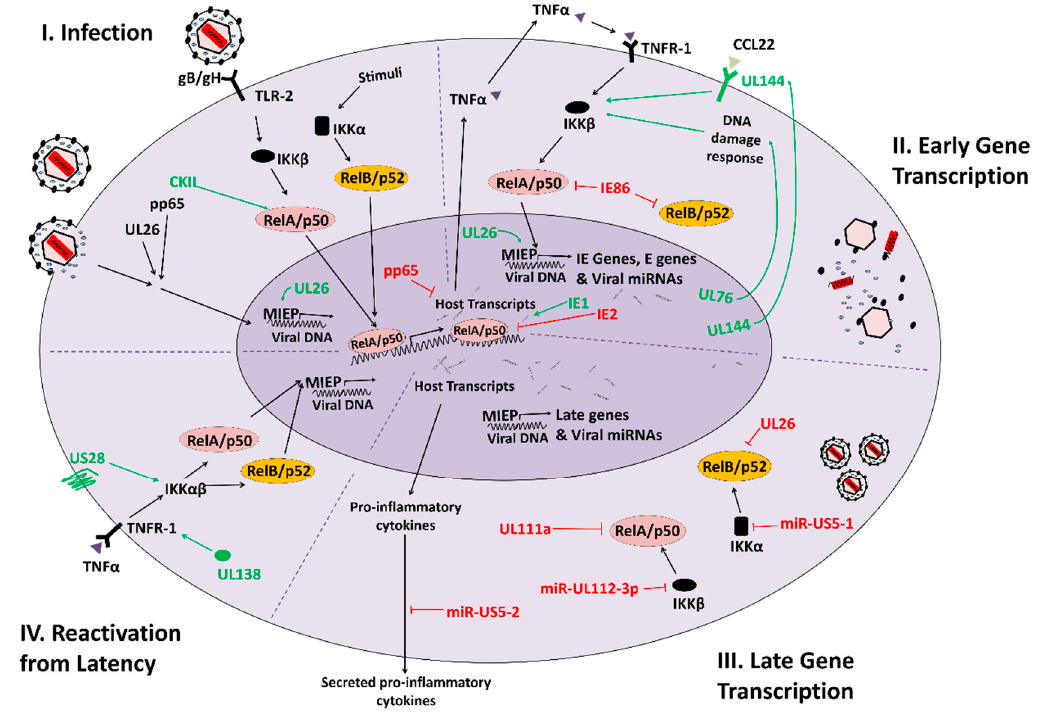
Figure 2. HCMV-mediated modulation of NF κ B signaling